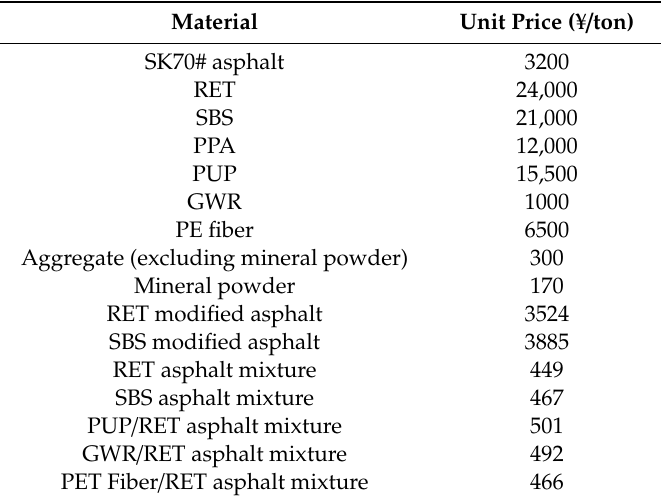
Table 11. Prices of materials per ton.